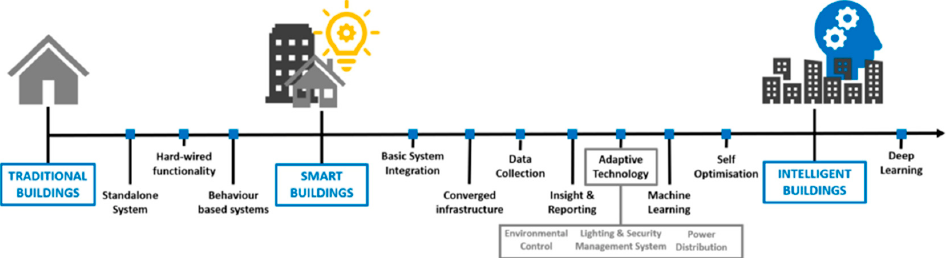
Figure 8. Evolution from traditional to smart techniques on buildings